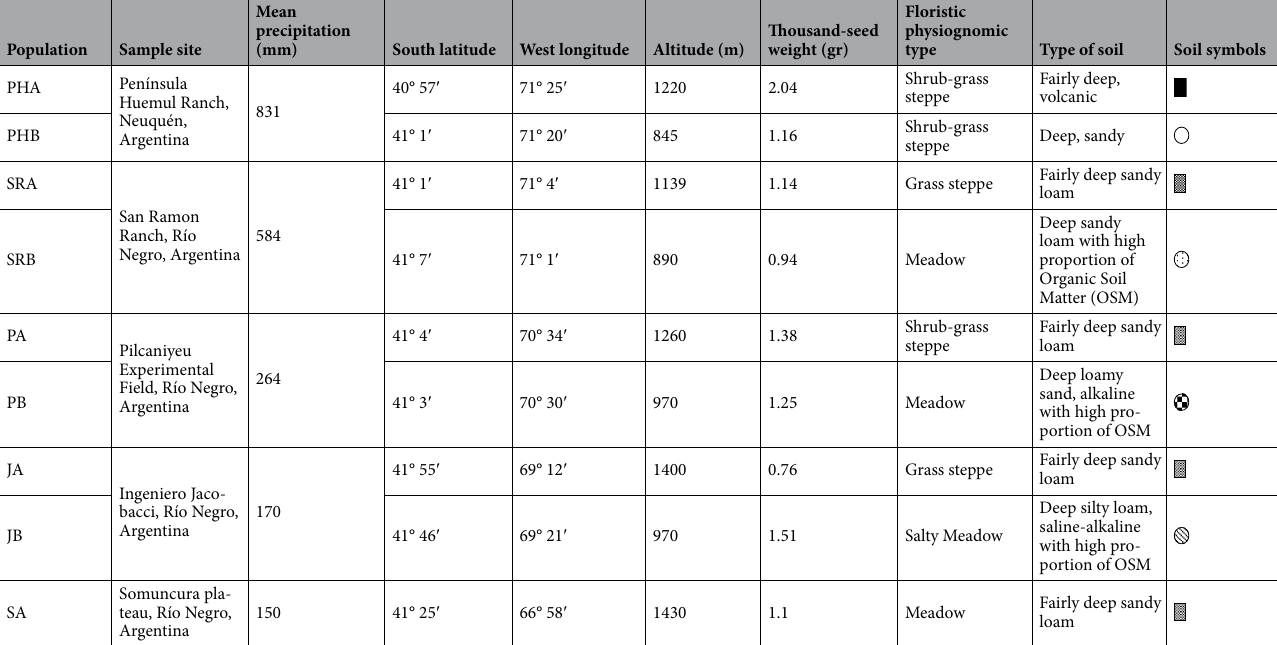
Table 1. Characteristics of the sampled Festuca pallescens populations: geographic location, thousand-seed weight and floristic physiognomic type 35 . Soil symbols correspond to those in Fig.